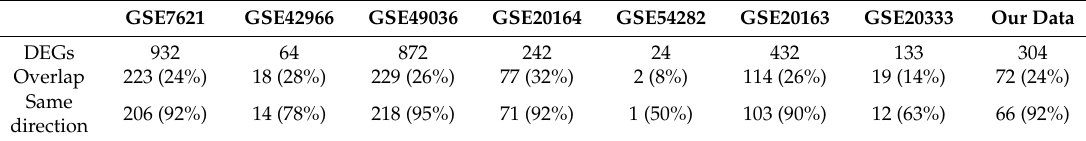
Table 3. Overlap between transcriptomic studies on the SN from PD